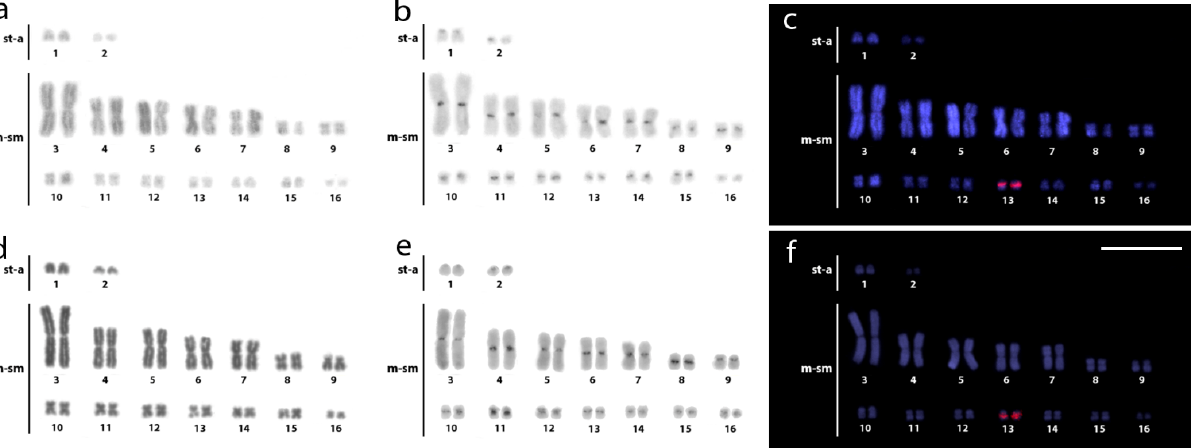
Figure 3. Female karyotypes of Alligator mississippiensis ( a – c ) and A. sinensis ( d – f ) arranged after inverted-DAPI staining ( a , d ), C-banding ( b , e ), and FISH analysis with 18S rDNA (red) probe ( c , f ). Bar = 20 µm.